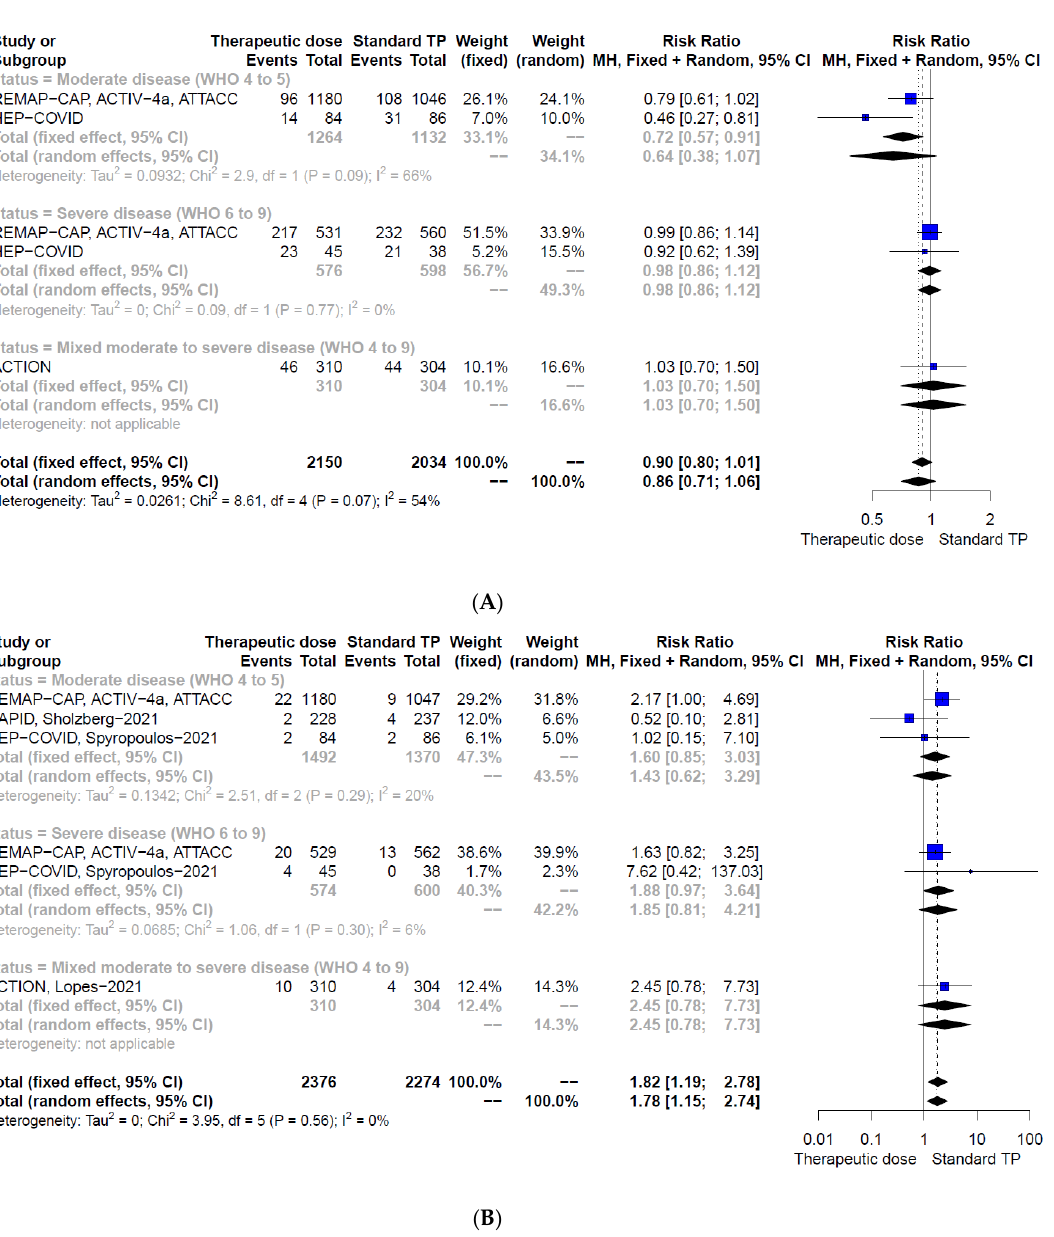
Figure 3. Forest plots according to pre-specified subgroups (moderately and severely diseased population) of therapeutic-dose anticoagulation vs. standard-dose thromboprophylaxis for the outcomes ( A ) any thrombotic event or death at 28 to 30 days and ( B ) major bleedings; CI, confidence interval; M – H, Mantel – Haenszel; TP, thromboprophylaxis.